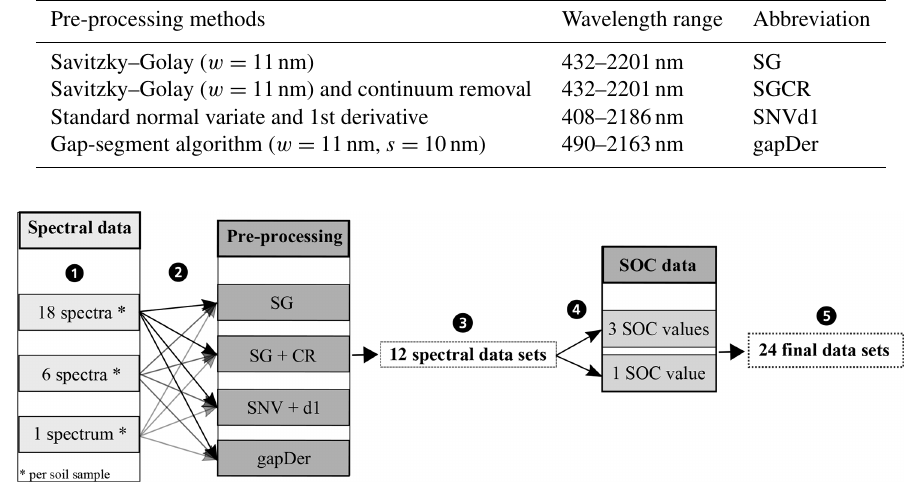
Table 1. Combinations of pre-processing techniques used in this study; w is window size, s segment size.